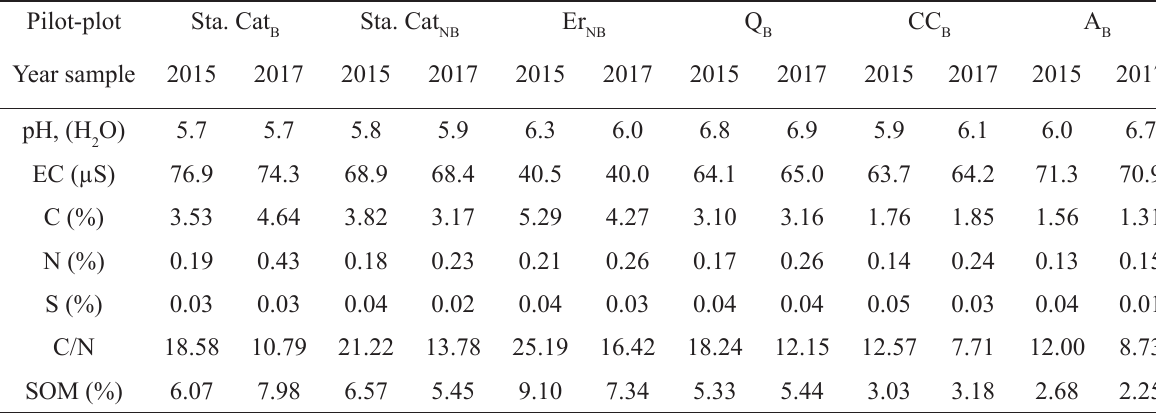
Table 2. Comparison of the general characteristics of topsoil (0-10 cm) in pilot-plots between the year after the last fire event (2015) and the three following years (2017). Values of the total soil carbon content (C), nitrogen (N), sulfur (S), carbon/nitrogen ratio (C/N), and soil organic matter content (SOM) are given in percentage. EC, Electric